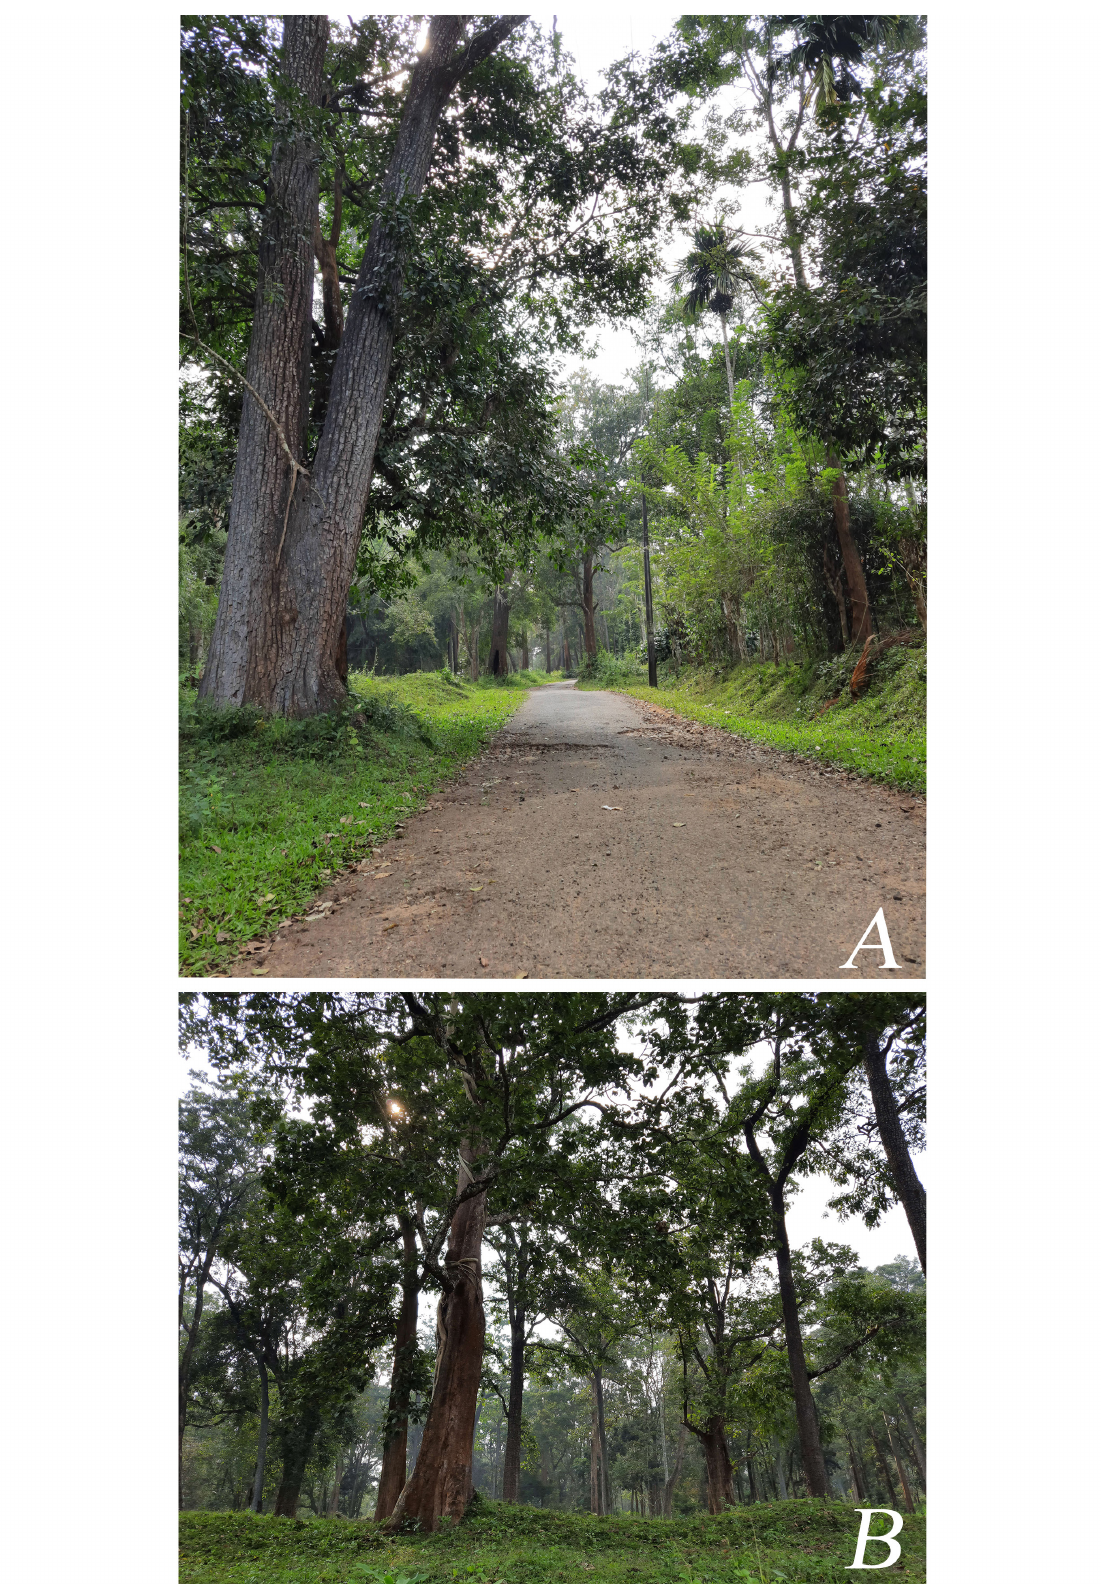
Fig. 17. Type locality of Isometrus wayanadensis sp. nov. Views of tall evergreen forest along road at the type